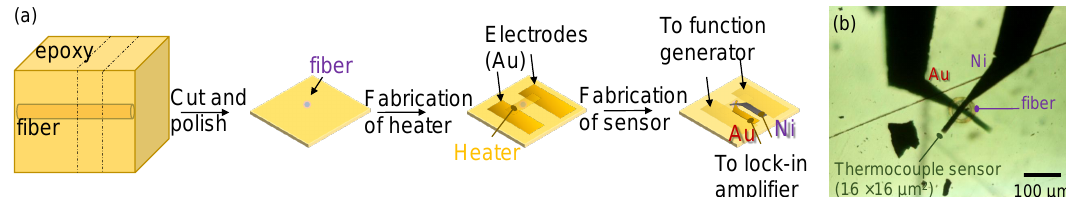
Figure A1. ( a ) Sample preparation and fabrication of heater and thermocouple on its ends for fibre samples. ( b ) Optical image of the sample made by process shown in ( a